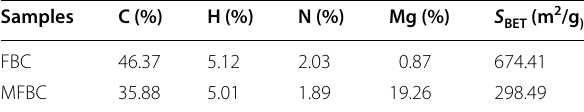
Table 1 Physiochemical properties of the biochars